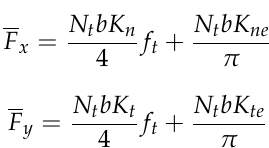
Table 1. Cutting parameters for cutting force coefficients.